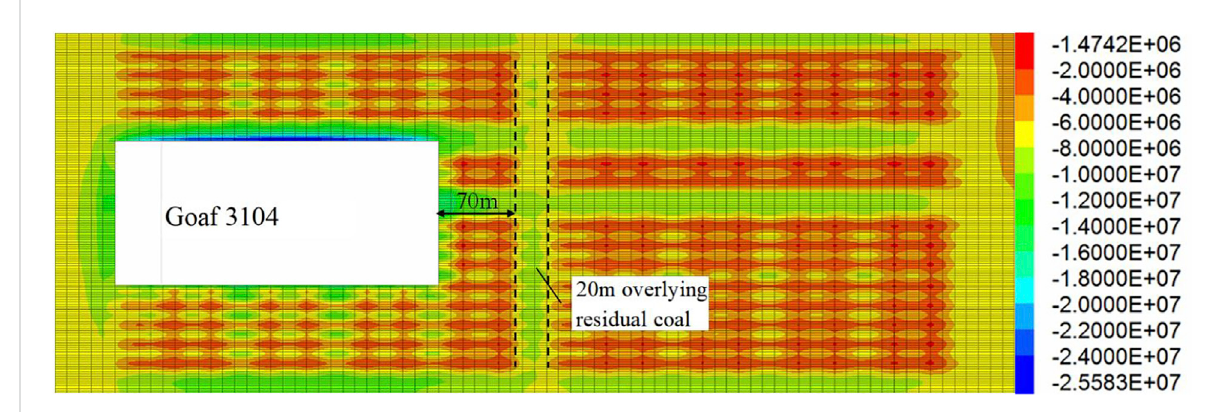
FIGURE 19 Cloud diagram of vertical stress distribution at 70m of overlying residual coal pillar (Pa).